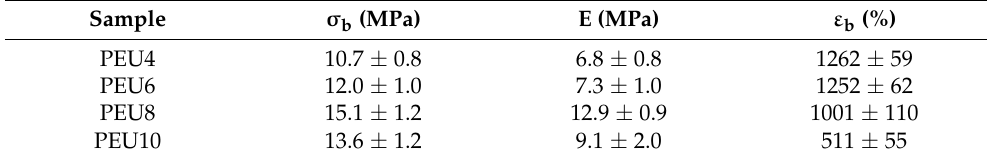
Table 5. Mechanical properties of